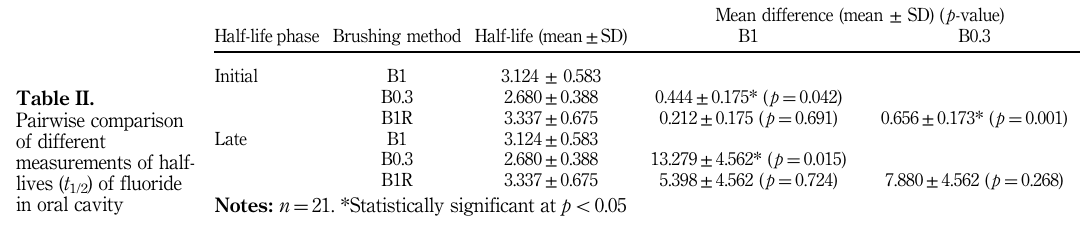
of different measurements of half- lives ( t 1/2 ) of fluoride in oral